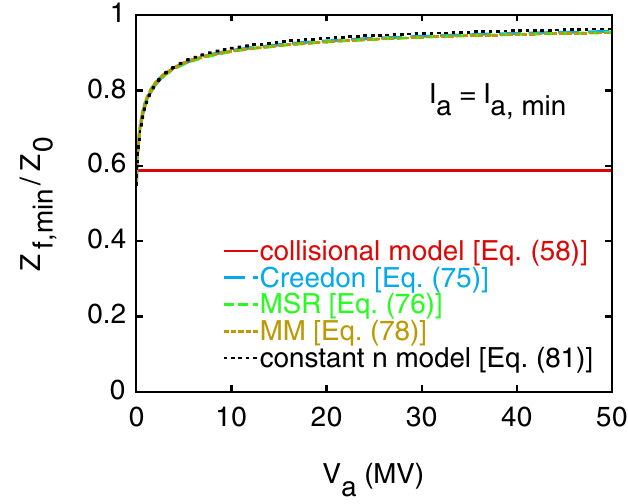
=Z FIG. 4. (Color) The ratio Z as a function of V for a 1D f; min a 0 (cid:14) 50 MV . The quantity planar MITL, plotted for 50 kV (cid:14) V a (cid:1) I Z is the flow impedance when I . The ratio is f; min a a; min plotted for the collisional model [Eq. (58)] and four collisionless models [Eqs. (75), (76), (78), and (81)]. Equation (75) is ob- tained by Creedon [8,9], Eq. (76) by Mendel, Seidel, and Rosenthal [27], and Eq. (78) by Miller and Mendel [30]. * [Eq. (81) is obtained in the present article.] When V a are expected 1 MV , experimentally observed values of Z f; min to fall between the collisional and collisionless